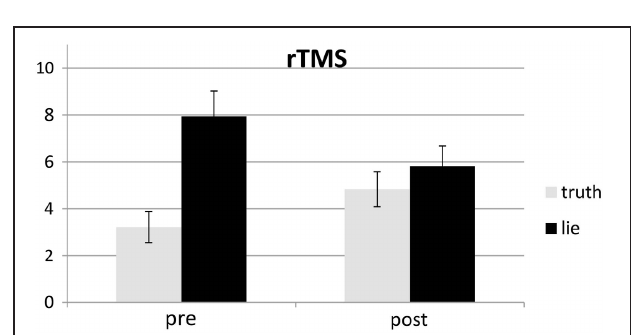
FIGURE 1 | Graphic representation of the MRI neuronavigated C-TBS at the right IFS. The inferior frontal sulcus (IFS) target point (red dot under the beam of the coil) for TMS, shown on the reconstruction of the right hemisphere of one exemplary participant. The target point is placed on the posterior part of the right IFS, in particular the area just anterior to the section of the precentral sulcus and the inferior frontal sulcus. In addition to the reconstruction of the right hemisphere of this participant, also the reconstruction of the head is displayed together with a simplified visualization of the coil. The tip of the red beam from the TMS figure-8 coil indicates the site of the maximal stimulation.